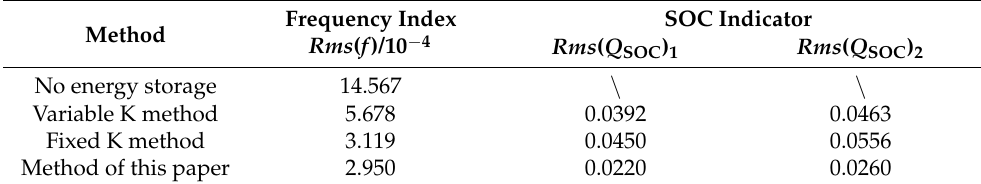
Table 2. Case 2: indicator statistics of frequency